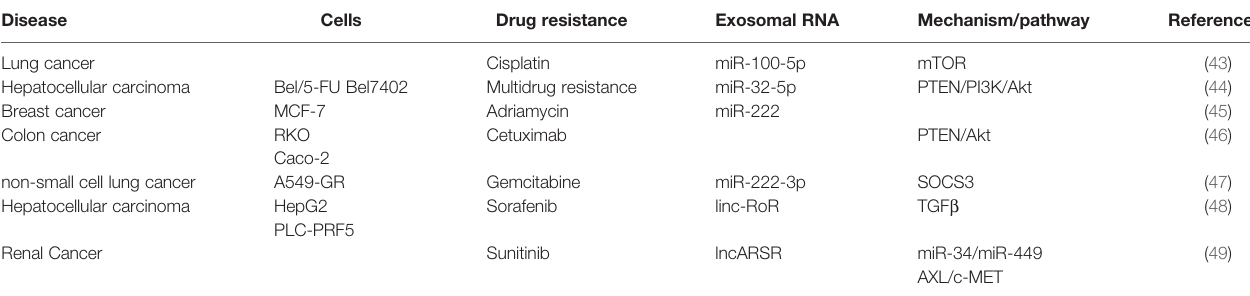
TABLE 1 | Signal transmission between drug-resistant cells and sensitive cells.